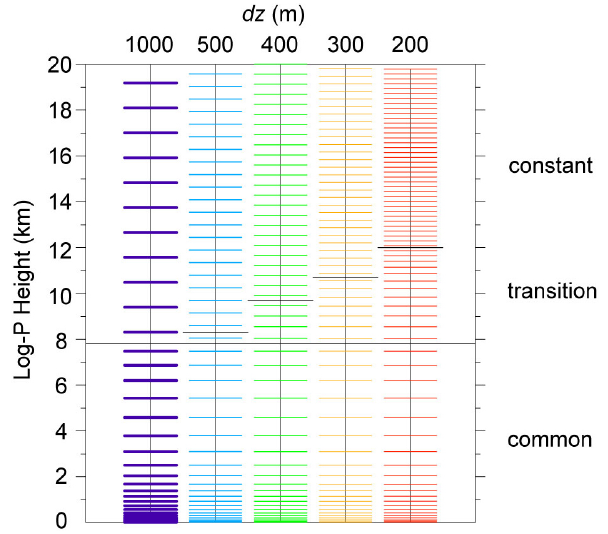
Figure A1. Standard vertical layer distribution for each vertical res- olution. Note that a hybrid sigma-pressure coordinate system was actually used in the model, and a scale height of 7km was used to calculate the log-pressure standard levels shown in this